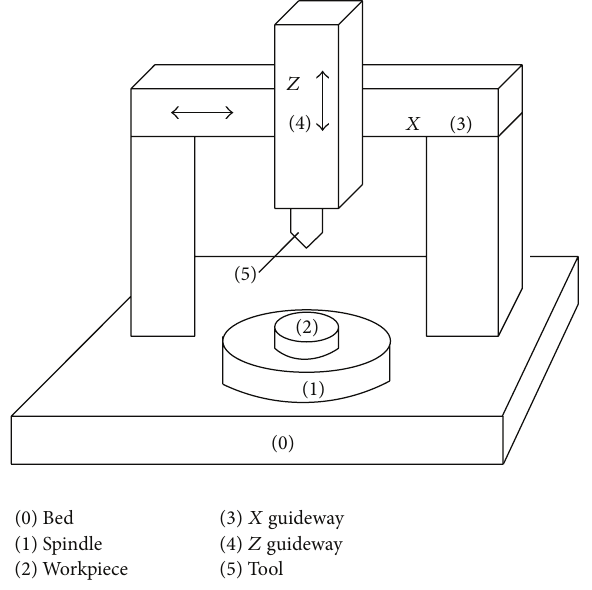
Figure 1: Scheme of the machine